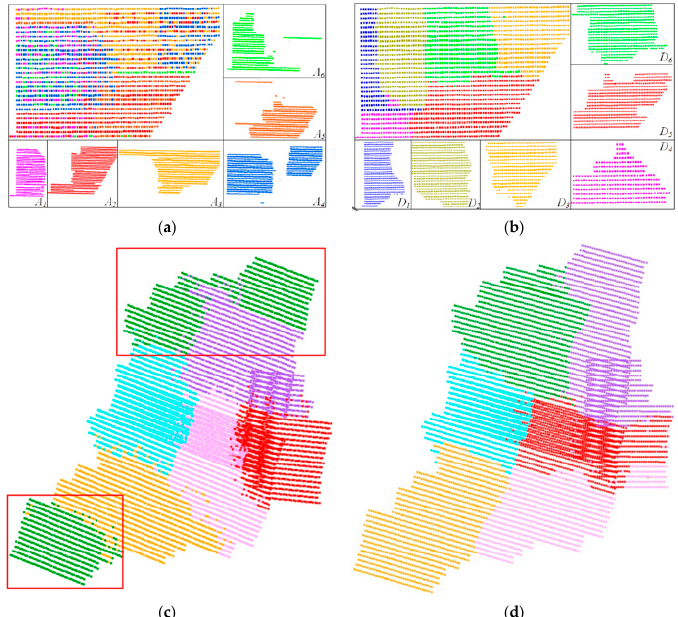
Figure 4. Comparison of image clustering results. The point set in the figure represents the position coordinates of the oblique image, and the same subcluster is represented by the same color. The left side is the result of the traditional method, and the right side is the result of the proposed method. ( a , b ) The dataset is Area 6, and the subcluster partition size is 1800, where the top left is the overall partition results, and 𝐴 (cid:2869) ~ 𝐴 (cid:2874) are the results of the six subclusters partitioned. ( c , d ) The dataset is Area 7, and the subcluster partition size is 5000.